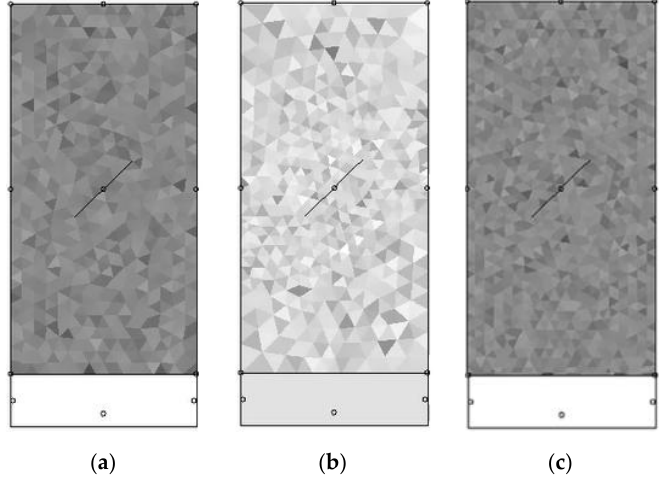
Figure 9. Rock models after grid generation for three cases: ( a ) Case 1; ( b ) Case 2; ( c ) Case